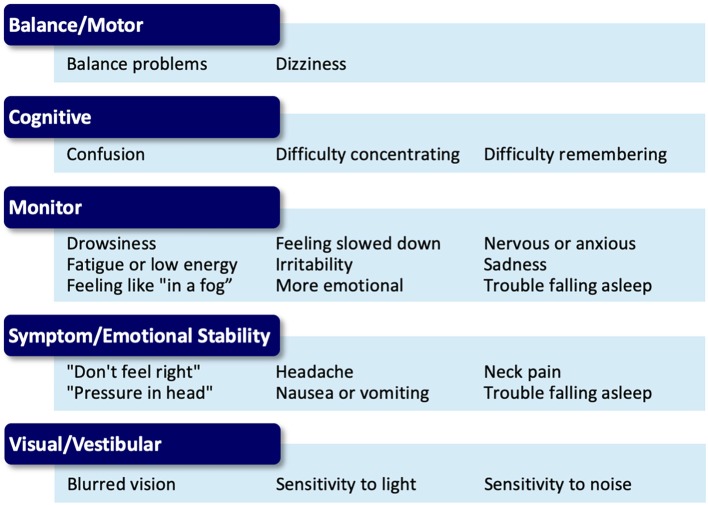
Symptom presentation and activity bucket matches for the Multidimensional Rehabilitation (MDR) progression.